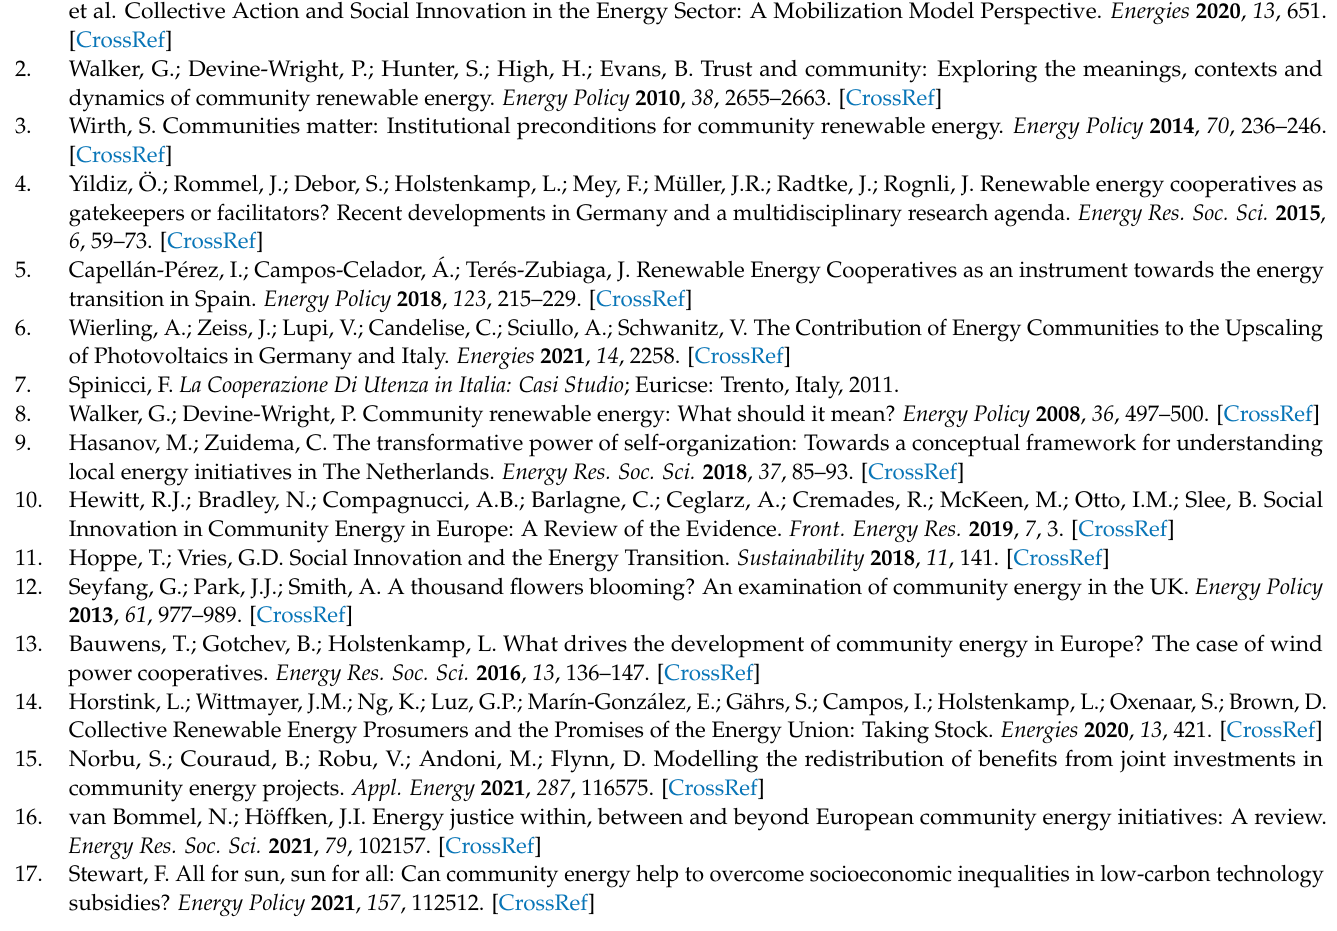
Figure A3. E-mobility Combinations, by country. Results in percentages.